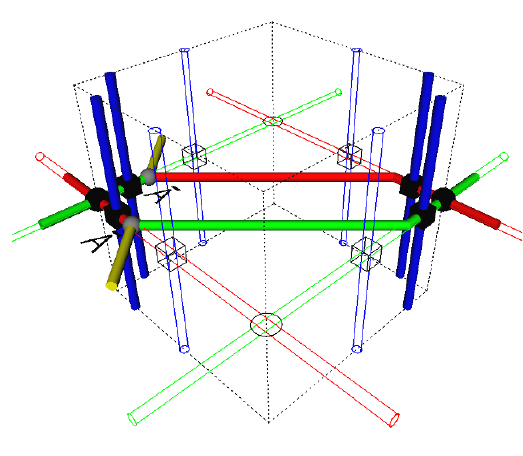
Figure 2 . Decomposition of A ( m; 0) at the m 0 = 0 sites. Gray spheres represent (cid:22) A .